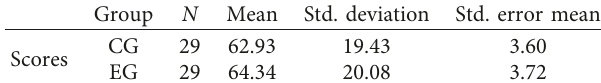
Table 1: Descriptive statistics (anxiety pretest of both